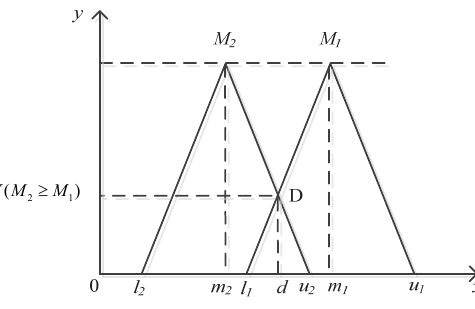
Fig.1 . The comparison two fuzzy numbers